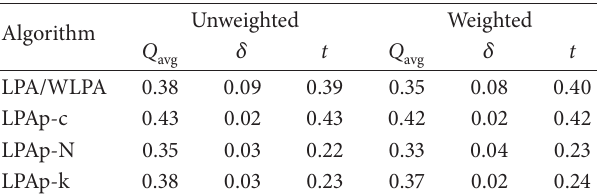
Table 2: The experimental result of LPA, LPAp-c, LPAp-N, and LPAp-k on computer-generated